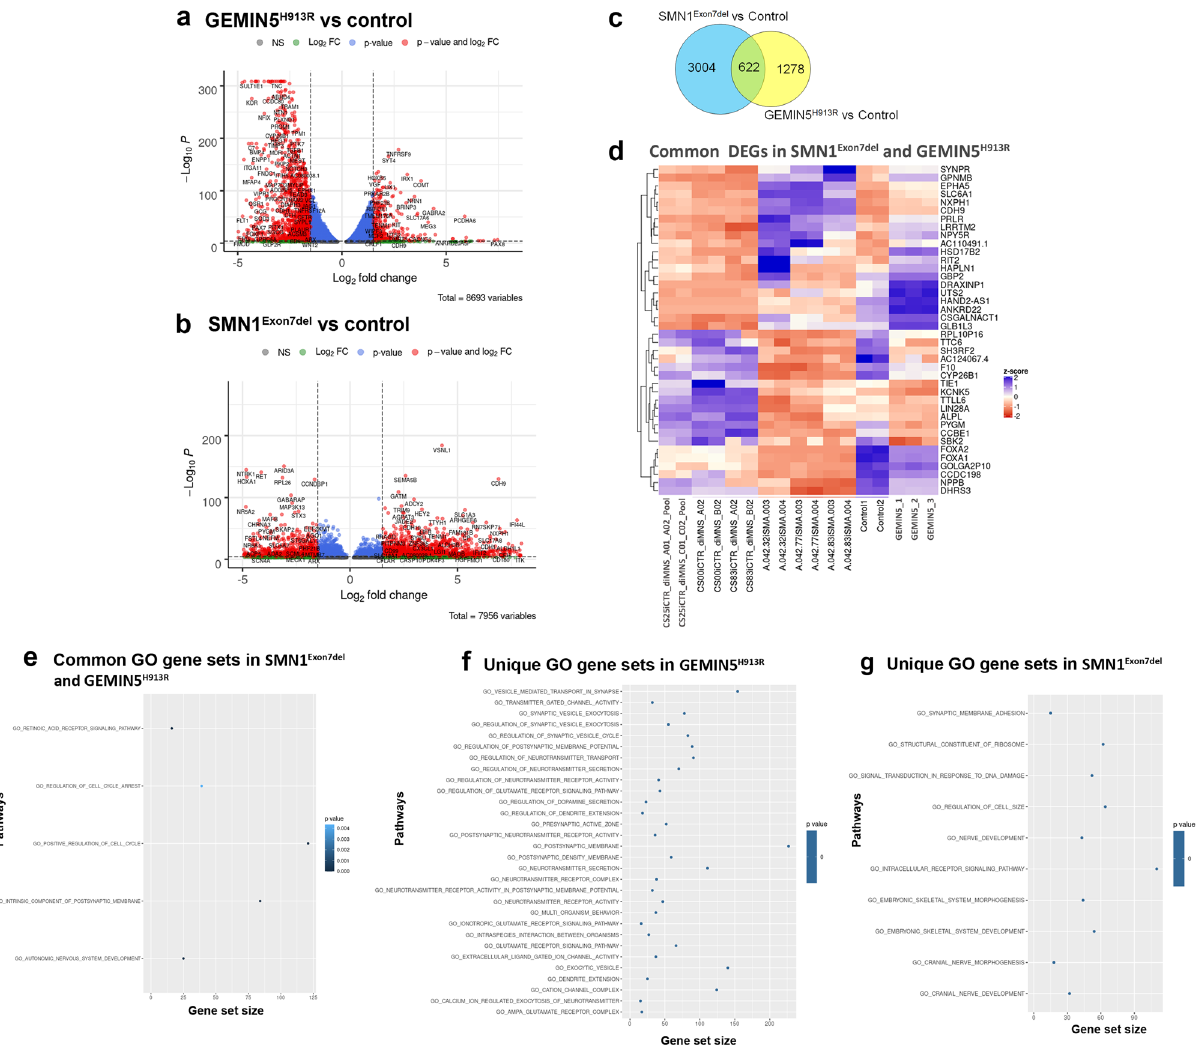
Fig. 6 RNA-seq analysis of GEMIN5 patient iPSC neurons reveals a distinct and unique transcriptomic pro fi le compared to SMA patient iPSC neurons. a , b Volcano plot showing up and down-regulated genes in SMN Exon7del vs. control ( a ) and, GEMIN5 H913R vs. control ( b ) selected by p -value < 0.01 & log2 (fold change) ≥ 1.5. The x -axes show log2 values of the fold changes in gene expression between the samples and y -axis shows − log10-transformed p - values. Signi fi cant genes were selected after Benjamini – Hochberg (BH) correction. c Venn diagram showing the number of genes that are shared between SMA and GEMIN5 and the genes which are exclusively to both. Only the DEGs with ≥ 1.5 log-fold DEGs were used for the comparison. d Heat map depicting the expression pattern of top 20 up and downregulated DEGs common to both SMN Exon7del and GEMIN5 H913R . Signi fi cant genes were selected by Wald test in DESeq2 and multiple test correction by BH. e – g Functional characterization of the genes with the MSigDB ‘ c5 Gene Ontology (GO), biological process ontology (BP) v6.0 ’ gene sets in SMN Exon7del and GEMIN5 H913R ( e ), unique to GEMIN5 H913R ( f ) and SMN Exon7del ( g ). The size of the dot corresponds to the number of genes per term, and the color of the dot indicates the enrichment signi fi cance. Source data are provided as a Source Data fi